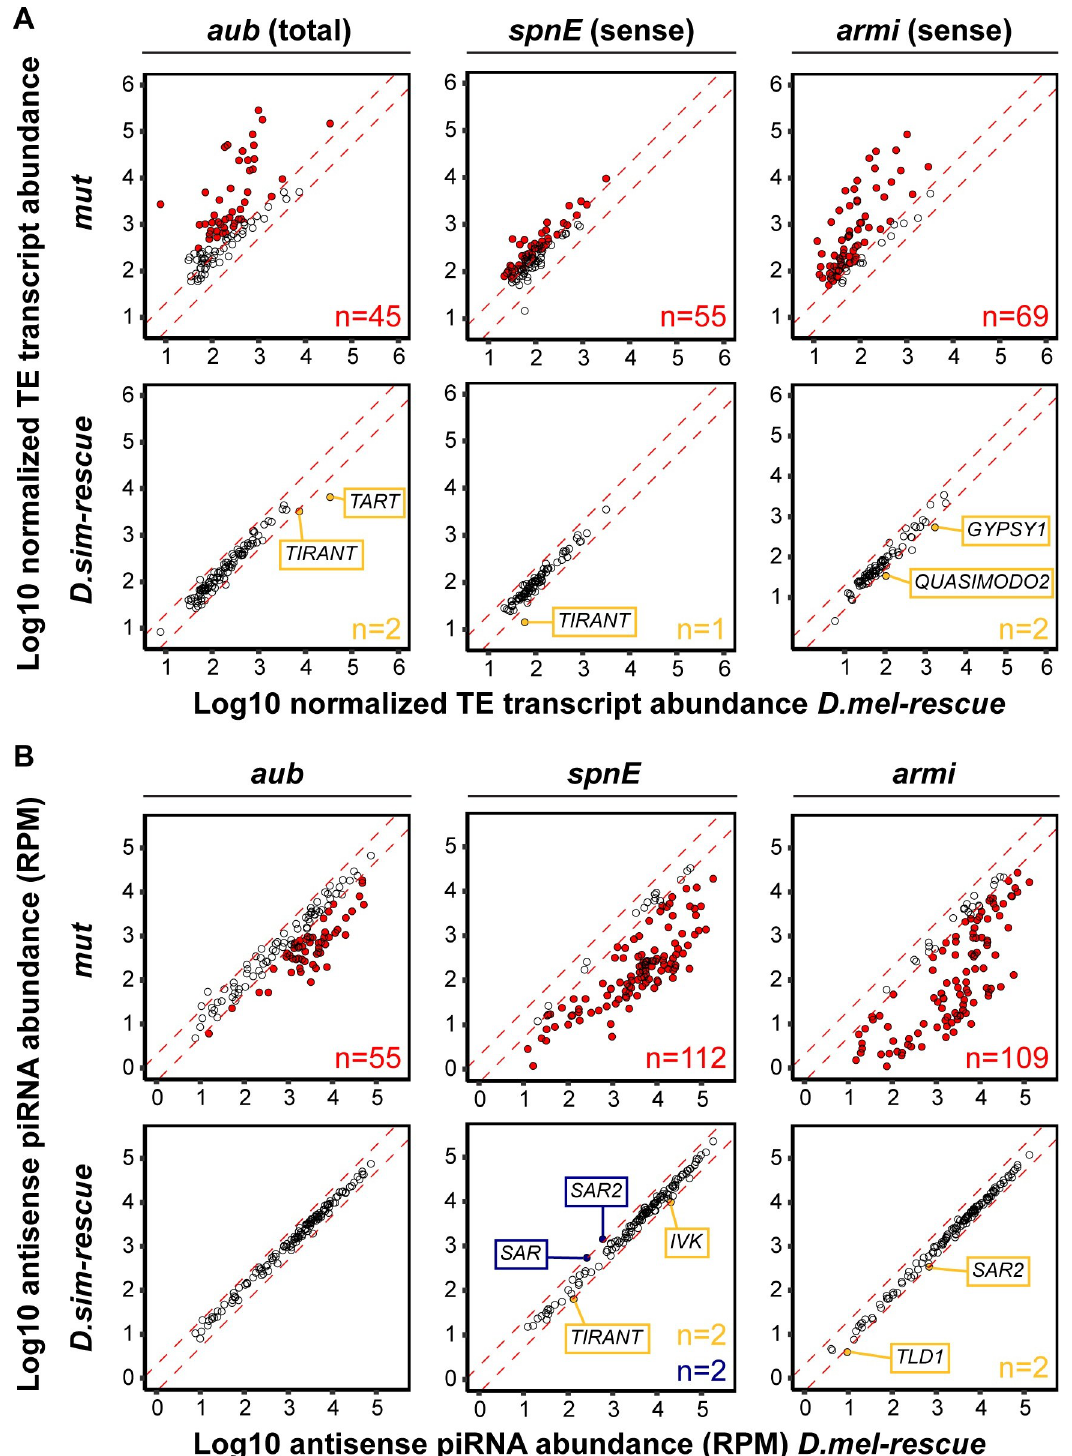
Fig 2. Minimal differences in TE regulation and piRNA production between alleles. TE transcript abundance (A) and TE- derived antisense piRNA abundance (B) is compared between D . melanogaster rescues and either trans-heterozygous mutants (“ mut ”, upper row) or D . simulans rescues (lower row) for aub , spn-E and armi . Red dashed lines indicate the two fold-change threshold. TE families whose abundance differs substantially between mutants and D . melanogaster rescues are indicated in red ( p < 0.05 for TE transcripts; > 2-fold for piRNA abundance). P -values were not considered for small RNA analysis because the